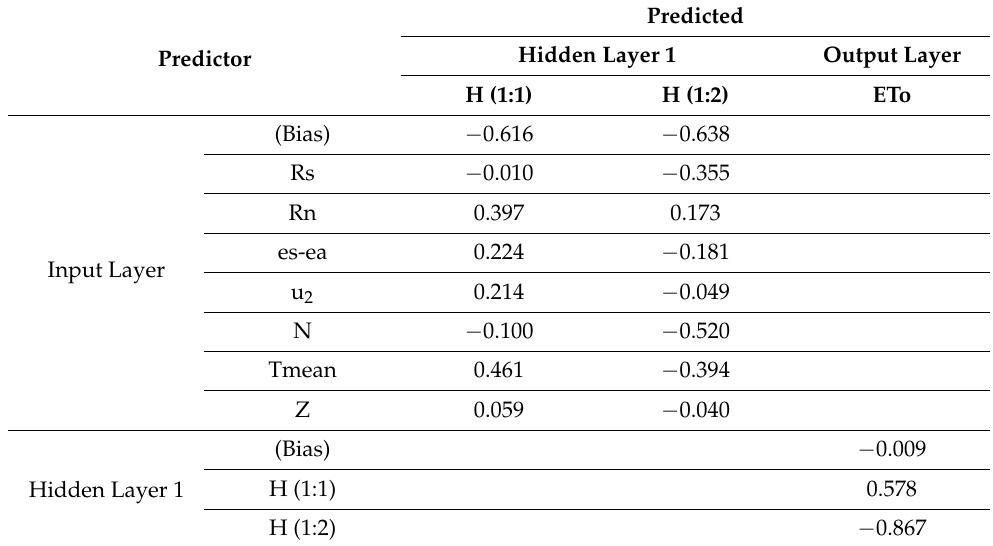
Table 3. Parameter estimates of the model with the best performance (MLP1).